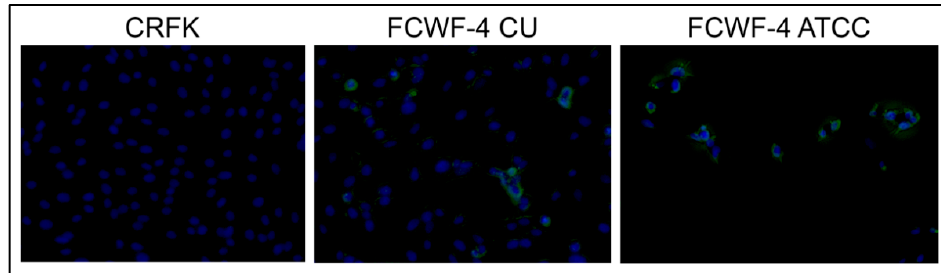
Figure 3. Comparison of cellular CD14 expression via immunofluorescence . CRFK cells demon- strate a lack of CD14 expression, and the two FCWF-4 cell line images have variable membranous expression by FCWF-4 cells (green fluorescence). Blue staining represents DAPI staining for cell nuclei. Green fluorescence represents FITC membranous CD14 staining.